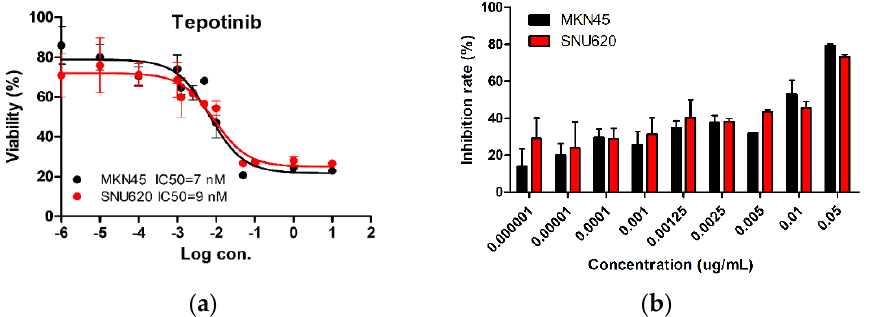
Figure 1. The effect of tepotinib in c-MET-amplified gastric cancer (GC) cells. SNU620 and MKN45 cells were treated with various concentrations of tepotinib for 48 h. ( a ) SNU620 and MKN45 cells were treated with tepotinib and viability was measured after 48 h. The IC 50 for tepotinib and condition is shown in the figure. ( b ) Relationship between activity and concentration of tepotinib against SNU620 and MKN45 cells. Data are means ± standard deviation. IC 50 : average 50% inhibitory concentration.